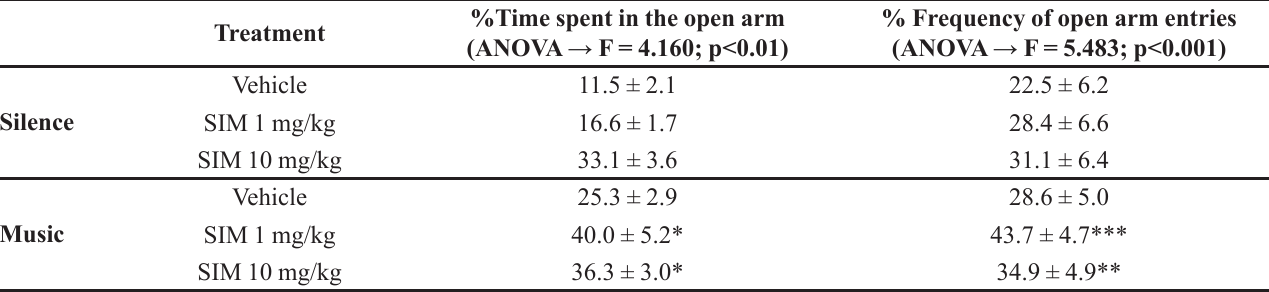
TABLE I – Effect of simvastatin (SIM, 1 and 10 mg/kg oral) on anxiety-like behavior in rats under each sound condition (silence and music) in the elevated plus-maze – percent time spent in the open arm and percent frequency of open arm entries. Values are expressed as the mean ± standard error of the mean; n = 10, *p<0.05, **p<0.01, and ***p<0.001. Statistically significant compared to the vehicle-silence group (analysis of variance [ANOVA] followed by the Newman-Keuls test)